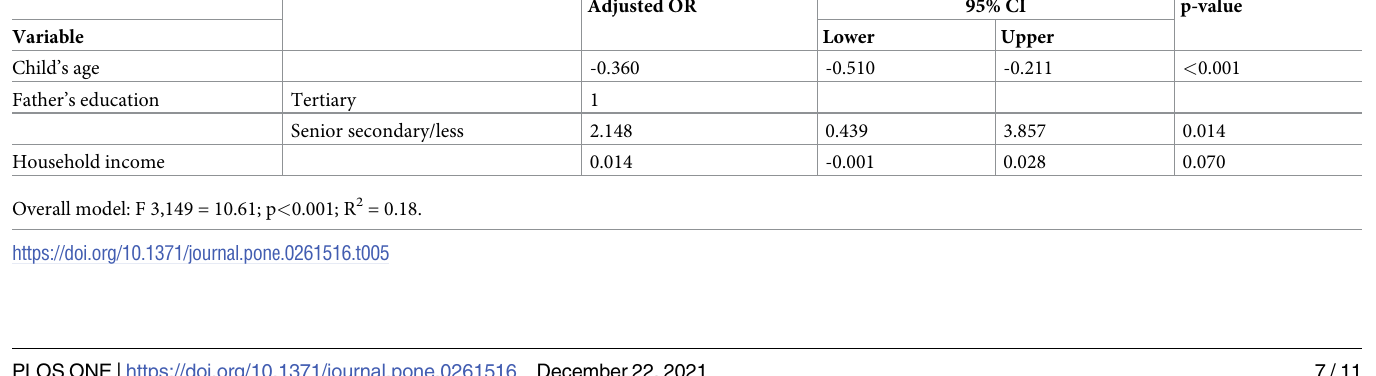
tion was weak. When the child’s age increased, adherence declined.